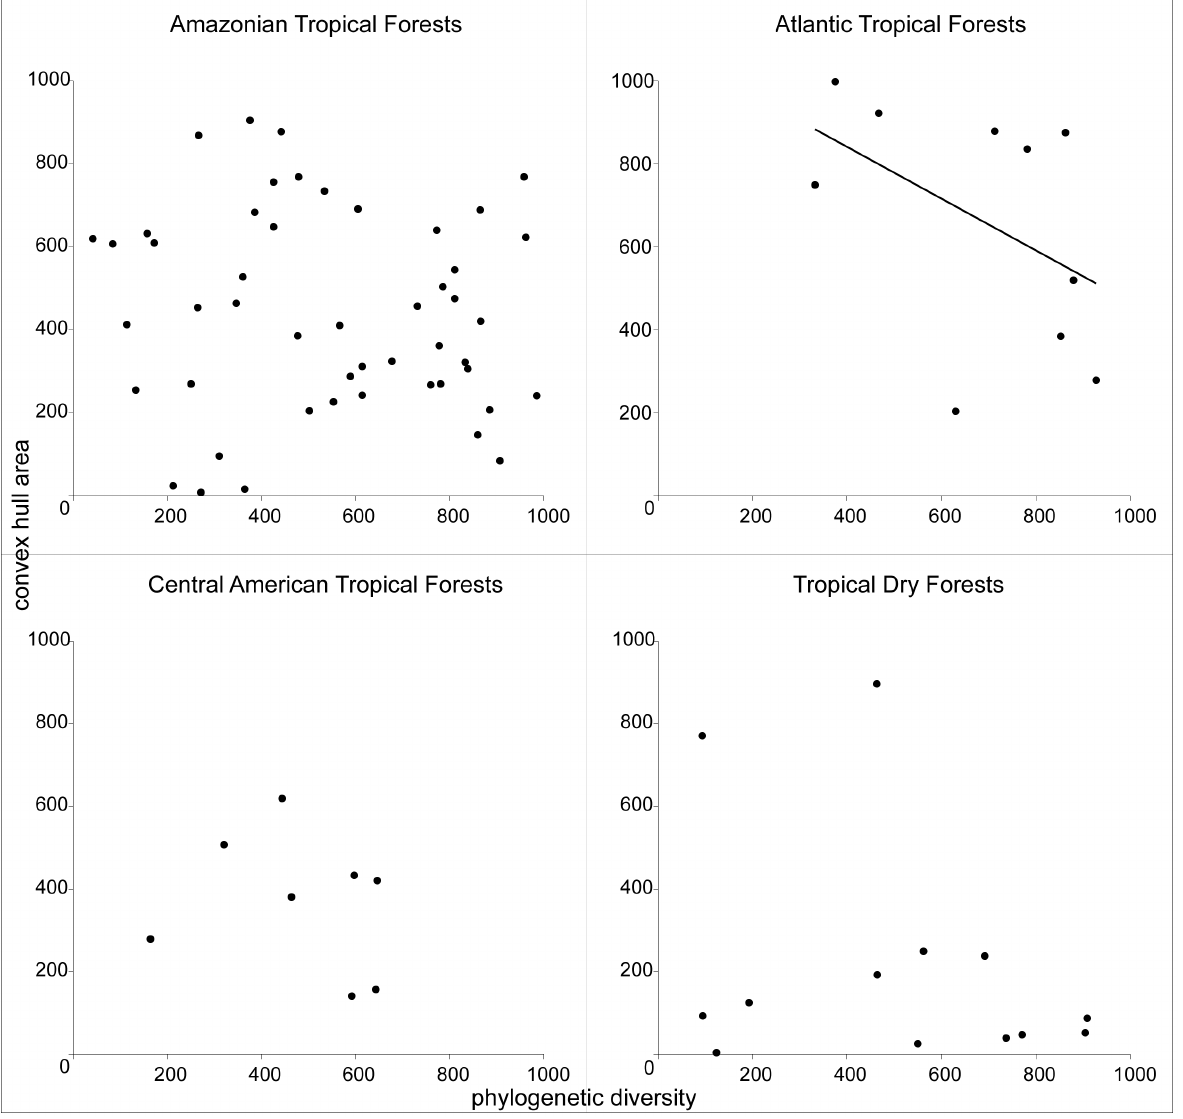
Figure 3. Floral diversity versus phylogenetic diversity in communities of Bignonieae in different habitats. Ranked values of (i) convex hull area, representing the morphological floral diversity, and (ii) phylogenetic diversity, calculated as the sum of phylogenetic branch lengths of the species in each community. The recorded points represent each of the communities located at the following habitats: Amazonian Tropical Forests; Atlantic Tropical Forests; Central American Tropical Forests; and Tropical Dry Forests.